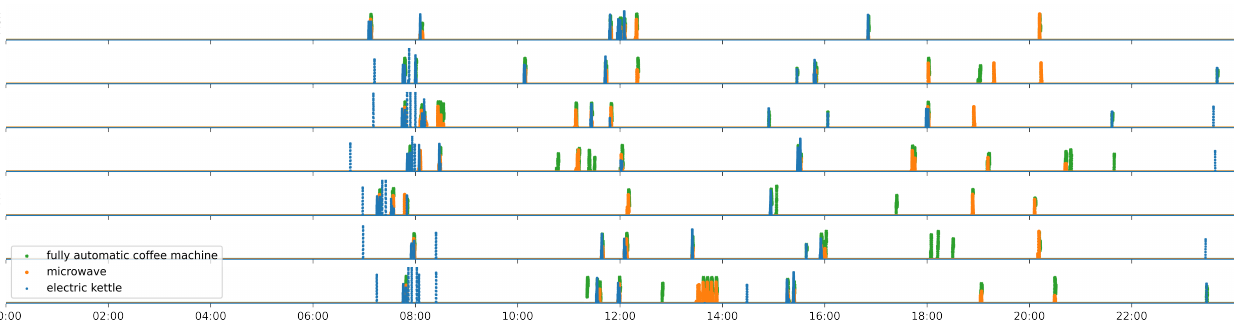
Figure 8. Human activity profile of household 07 of the ’GeLaP’ dataset in the period from 28 October to 3 November 2019, which was created using the presented NILM methodology on the smart meter data for the appliances fully automatic coffee machine, microwave, and electric kettle. Values between 0 and 1 are possible on the Y-axis, which show the Pearson-R correlation of the corresponding motifs to the aggregated data. The higher the value, the better the agreement between the motif and the aggregated